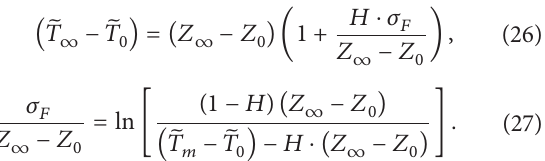
Figure 3: Normalized mass burning rate 𝑚/𝑚 𝑎 for the stoichiomet- ric Si-C system as a function of the heat loss parameter Ψ , with the heat-input parameter 𝐻 taken as a parameter. An open circle designates the limit of